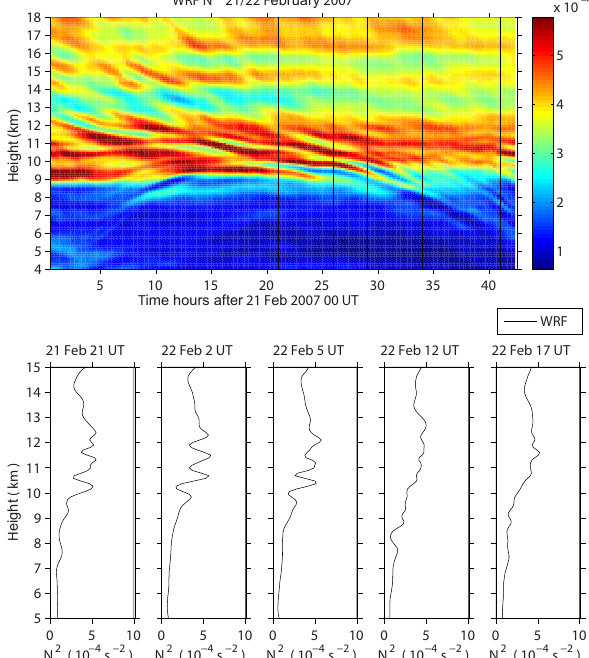
Figure 2. Time-height diagram of N 2 (in s − 2 , colours), from the WRF model experiment (same time and height axes as Fig. 1). Pro- files of N 2 obtained by the WRF data at 21:00UTC 21 February 2007, 02:00, 05:00, 12:00 and 17:00UTC 22 February 2007, corre- sponding to the radiosonde